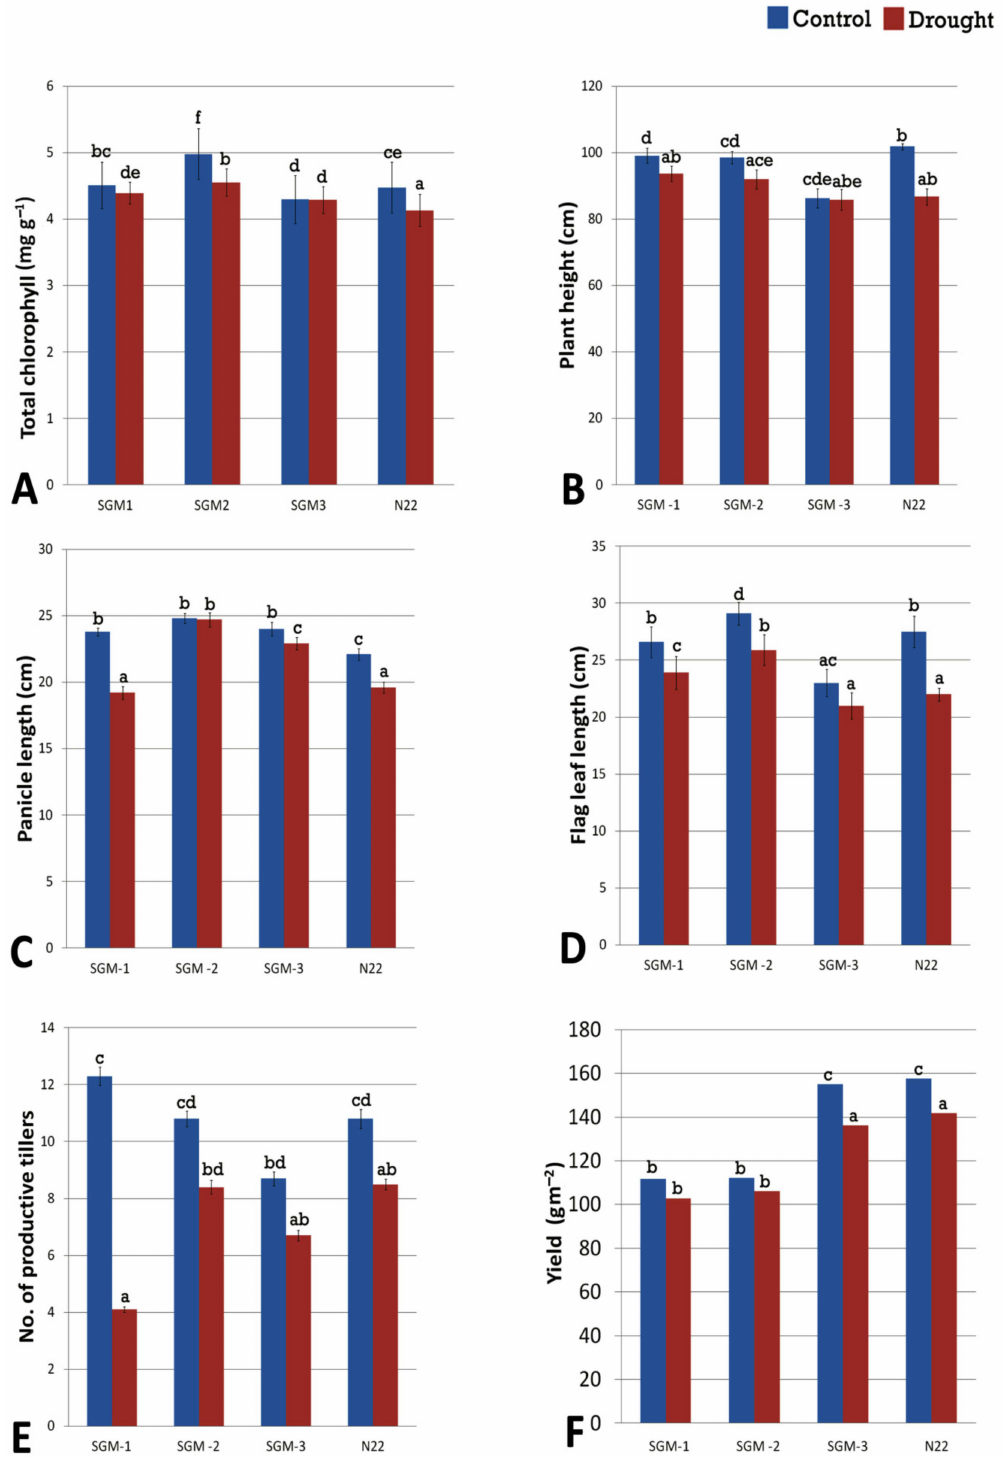
Figure 5. Performance of the three stay-green mutants (SGM-1 to SGM-3) and the wild type, Nagina 22 (N22) for ( A ) chlorophyll content, ( B ) plant height, ( C ) panicle length, ( D ) flag leaf length, ( E ) number of productive tillers, ( F ) plot yield under well-watered (control) and drought stress conditions (a to e denotes significance at p (0.05) determined from one way ANOVA post hoc Tukey